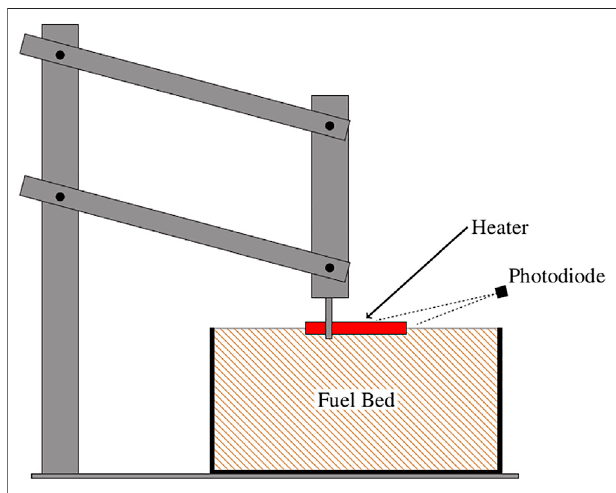
FIGURE1| Experimentalapparatusfortheignitionpropensitytests.The lever arm used to lower the apparatus into the fuel bed, the fuel bed size relative to the heater, and the location of the photodiode are